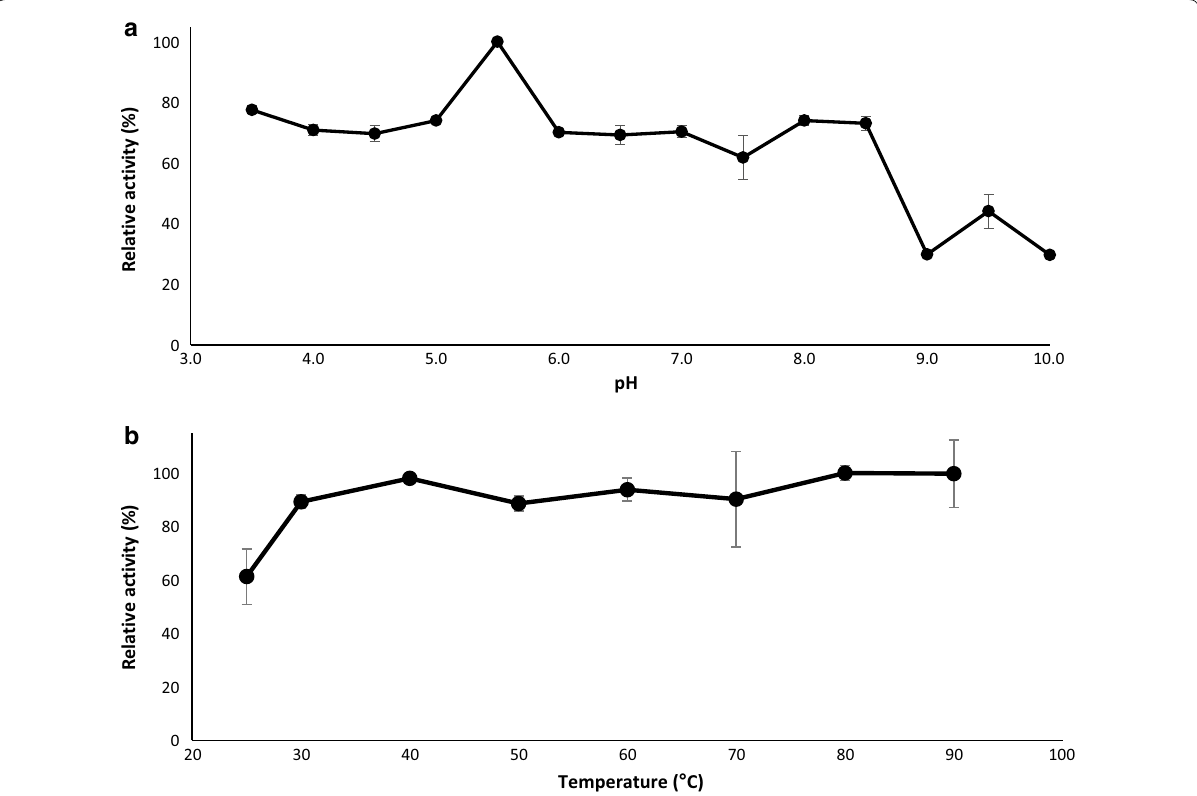
Fig. 3 Optimum pH ( a ) and temperature ( b ) profiles of Sc Lac. a The activity of the laccase was measured against 20 µM DMP at 30 °C in buffers with various pH values ranging from pH 3.5–10.0. b The activity of the laccase was measured against 20 µM DMP after incubation for 5 min in the optimal buffer system in a temperature range from 25 to 90